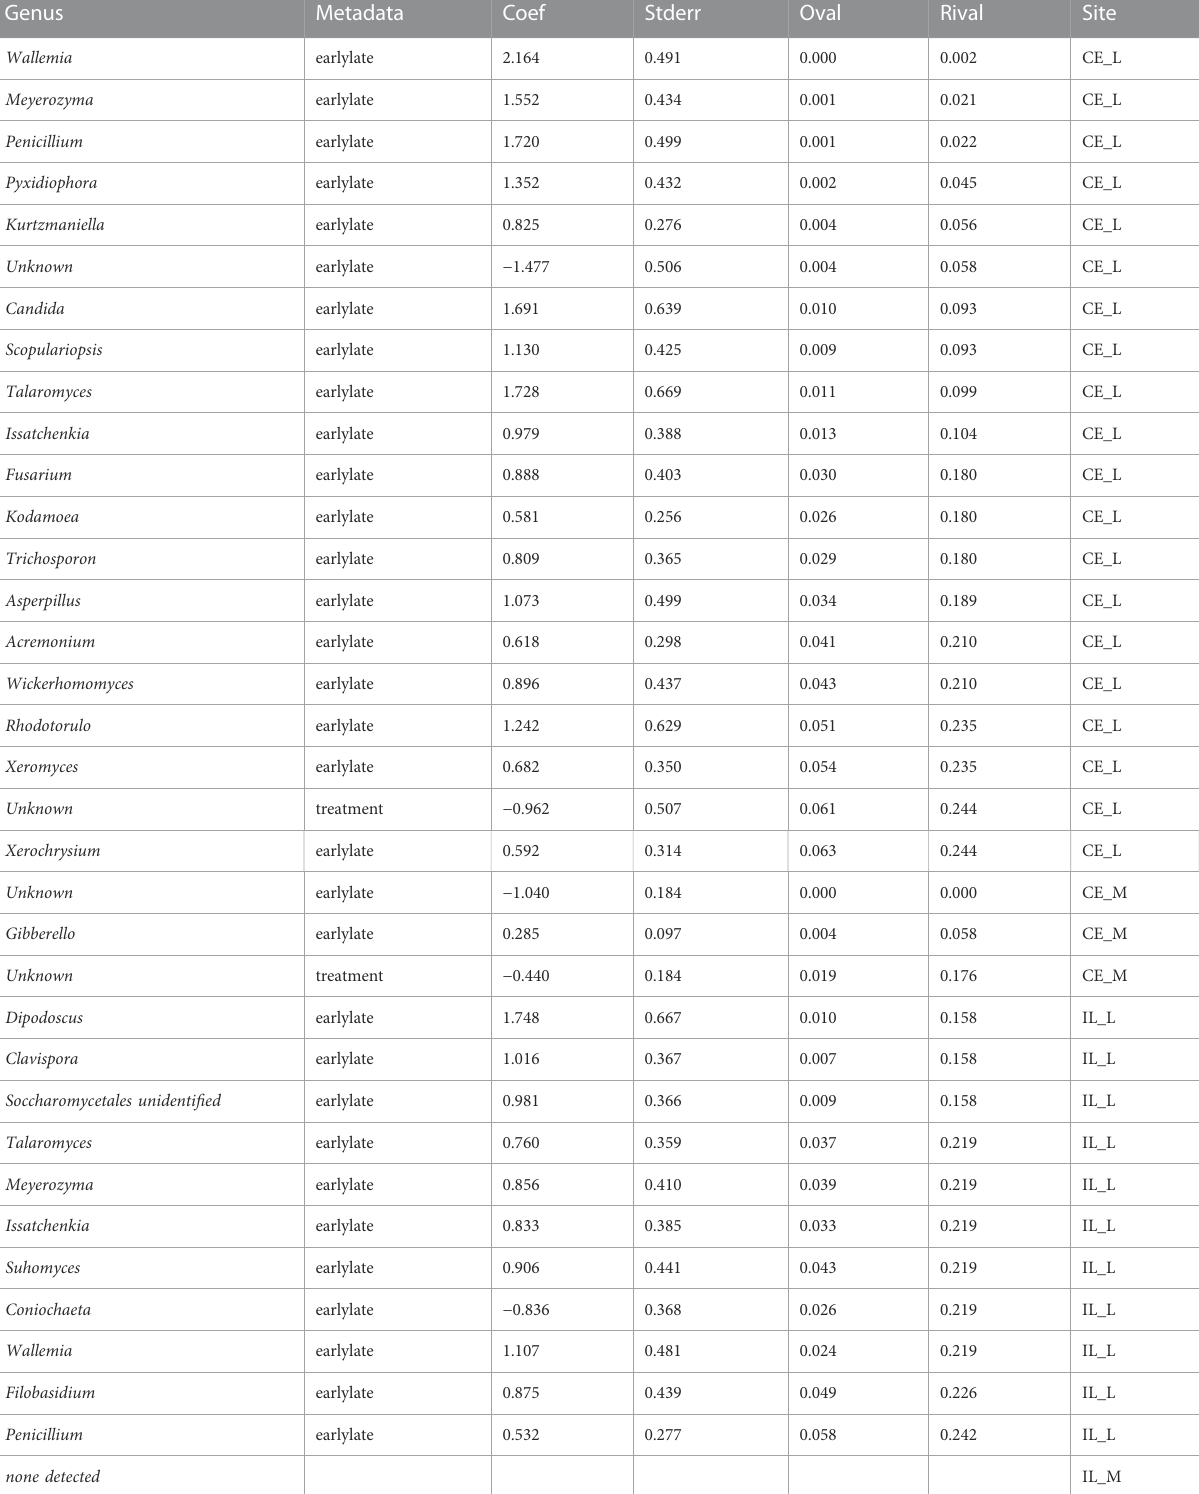
TABLE 3 List of genera which are differentially abundant across time and treatment. For each genus, the model coef fi cient, standard error, p -values, FDR corrected p -values (q-values) are also listed.